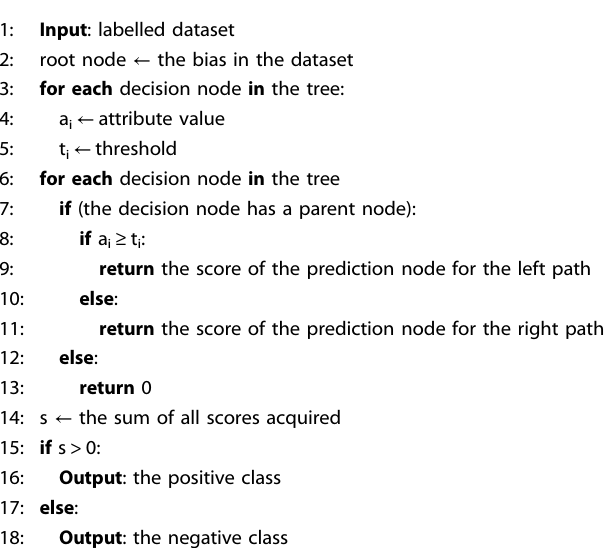
Algorithm 4 . The algorithm of ADTree model 165